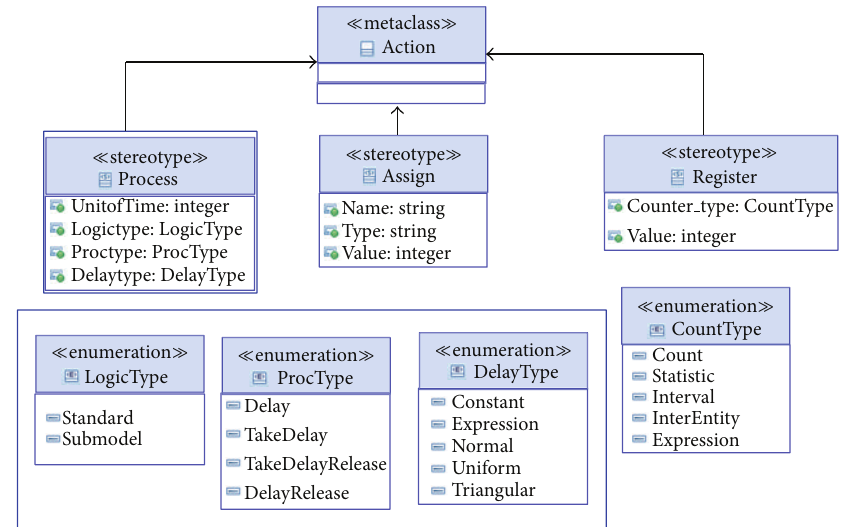
Figure 6: The metaclass action and its stereotypes.